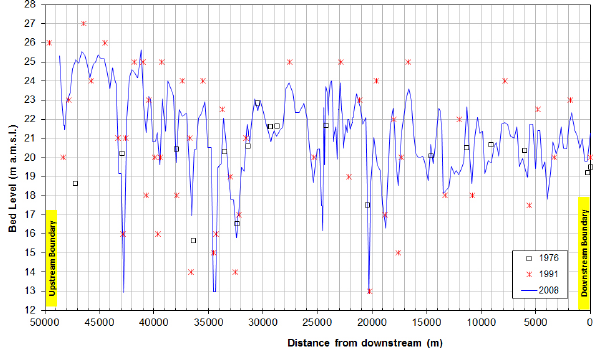
Fig. 8. Tigris River bed elevations during 1976, 1991 and 2008.